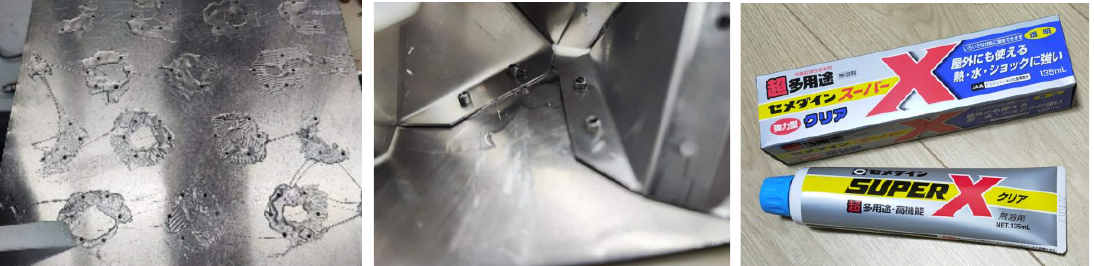
Figure 13. Assembled truss core panel joined using glue and rivets.